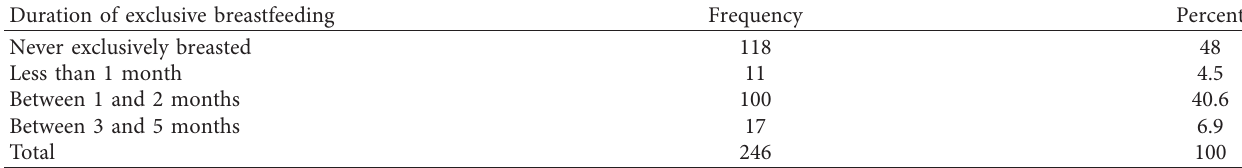
Table 3: Duration of exclusive breastfeeding among women in west Shoa zone.